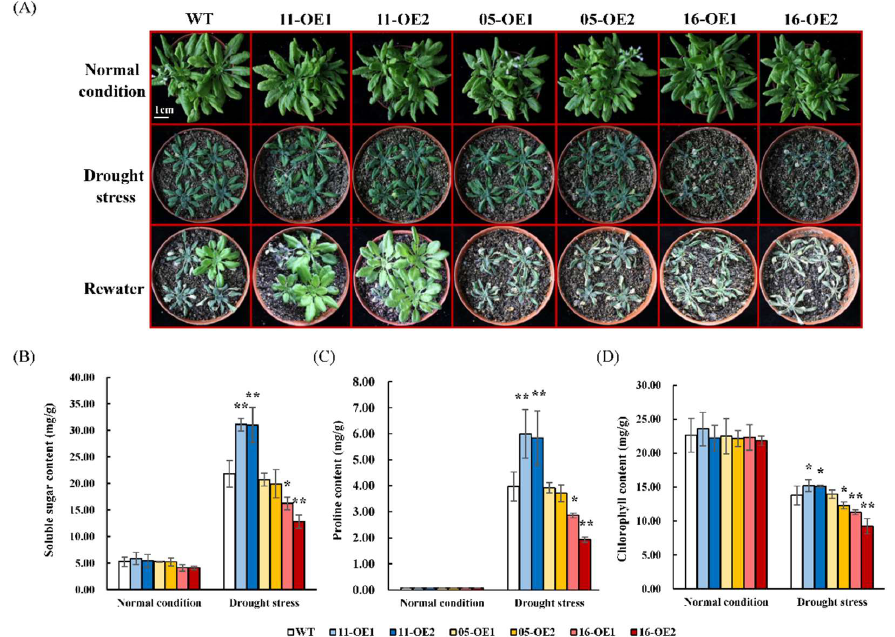
Figure 7. Analysis of drought tolerance in the adult stage. ( A ) WT and transgenic plants were grown in soil with sufficient water for one month before water was withheld for 15 days, after which the plants were allowed to recover for 7 days. Bars = 1 cm. ( B – D ) The proline, soluble sugar, and chlorophyll contents in the WT, 11-OE1/OE2, 05-OE1/OE2, and 16-OE1/OE2 plants. Error bars represent SDs for three independent replicates. Asterisks indicate statistical difference ( * p < 0.05, ** p < 0.01) compared to the WT. ** p < 0.01) compared to the